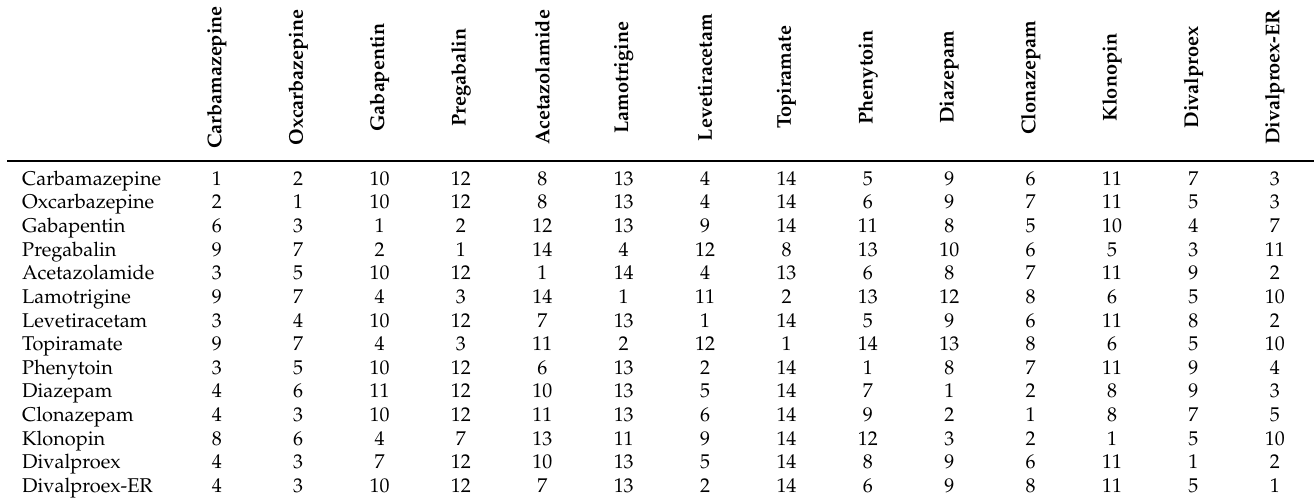
Table 8. Drug-Drug Similarity-based Rankings of AEDs using MD Measure.